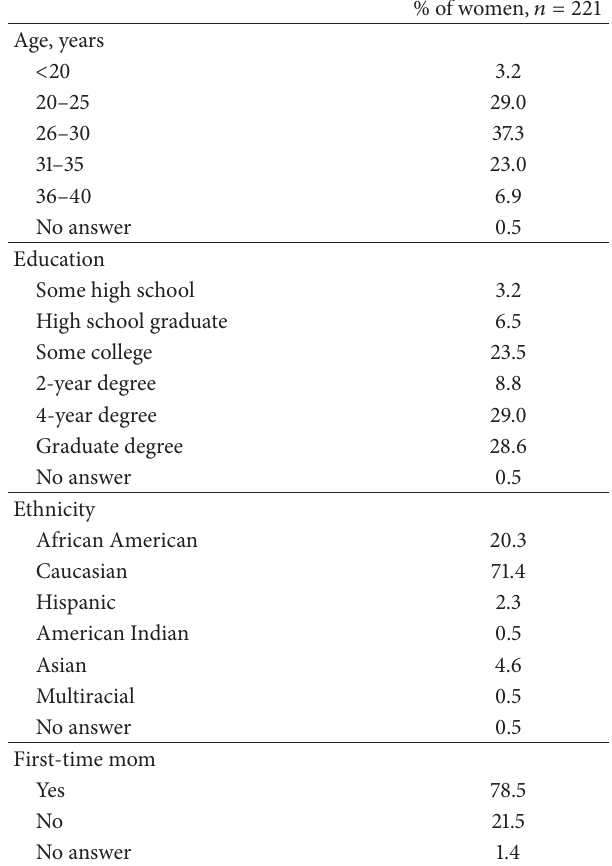
Table 2: Demographics of the survey population.